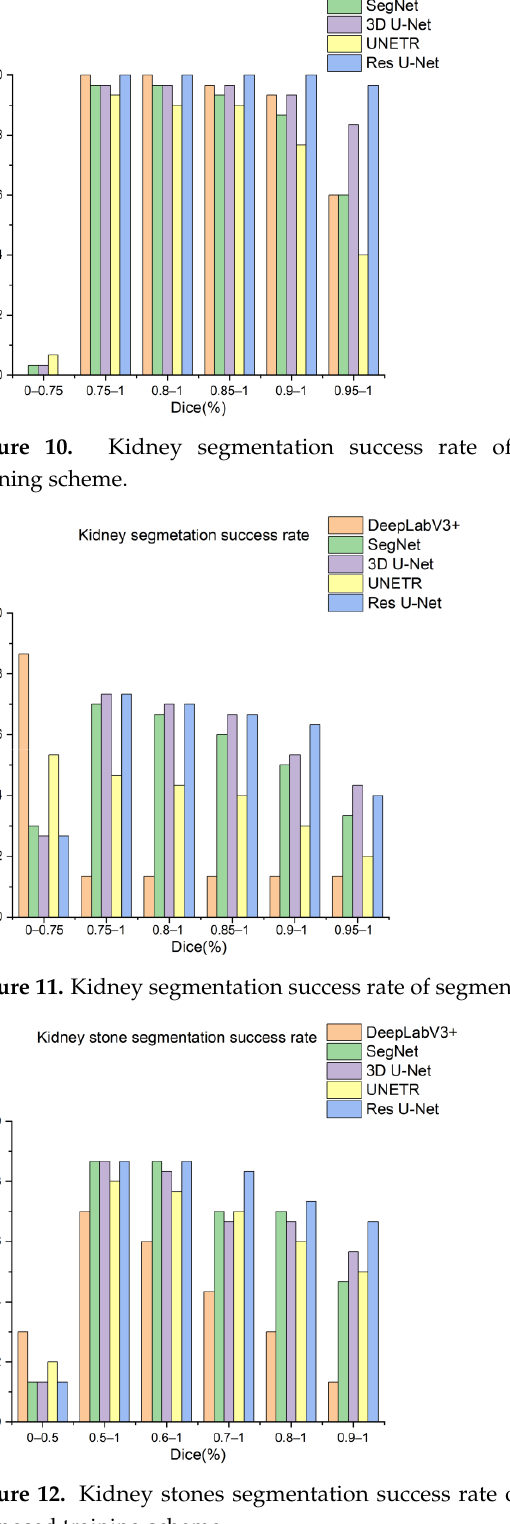
Figure 13. Kidney stones segmentation predictions success rate of segmentation networks trained independently. A comparison of Figures 14 and 15 shows that the models trained with the proposed training procedure gave better segmented predictions. The Res U-Net showed the highest performance, followed by other trained networks using test data. The 3D U-Net was a close competitor to Res U-Net. Otherwise, DeepLabV3+, UNETR, and SegNet missed some of the target regions belonging to kidneys and kidney stones. Both Figures 14 and